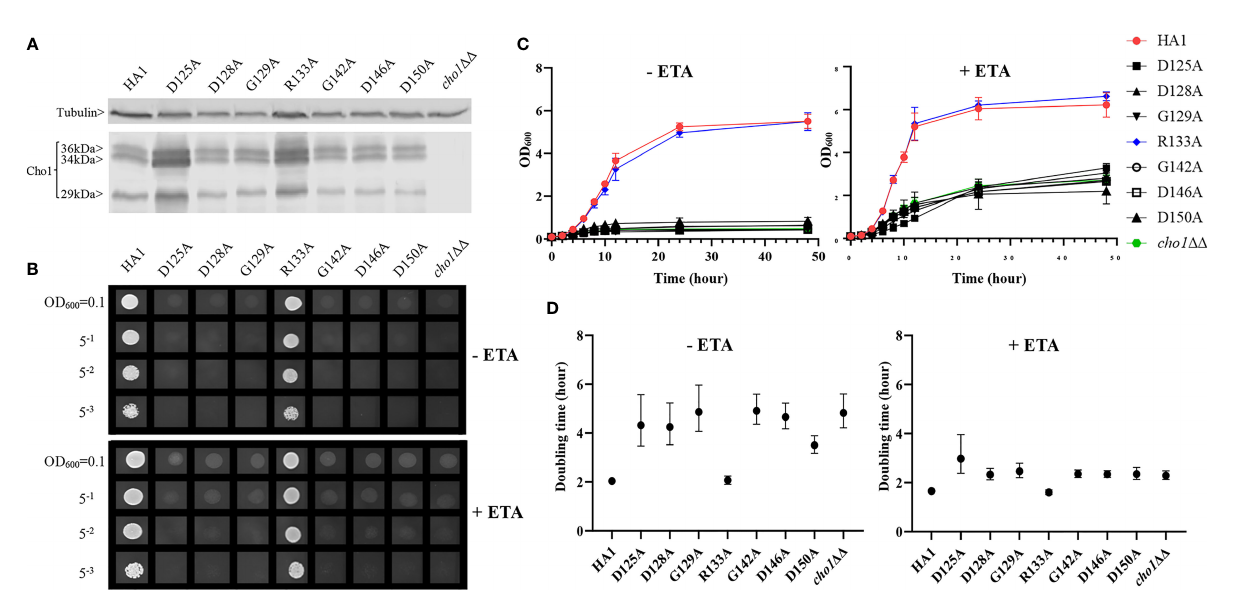
FIGURE 2 | Most conserved CAPT mutants displayed defects in ethanolamine-dependent growth. (A) Cho1 protein expression was measured from the cell lysates of cho1 DD , HA1, and the CAPT motif mutant strains via western blotting. The impact of CAPT mutations on ethanolamine-dependent growth was measured by (B) spot dilution assays, (C) growth curves, and (D) doubling times from corresponding growth curves. Error bars in (D) represent the 95% asymmetrical (pro fi le- likelihood) con fi dence intervals of each doubling time from a total of six replicates. (+ETA, minimal media+1 mM ethanolamine; -ETA, minimal